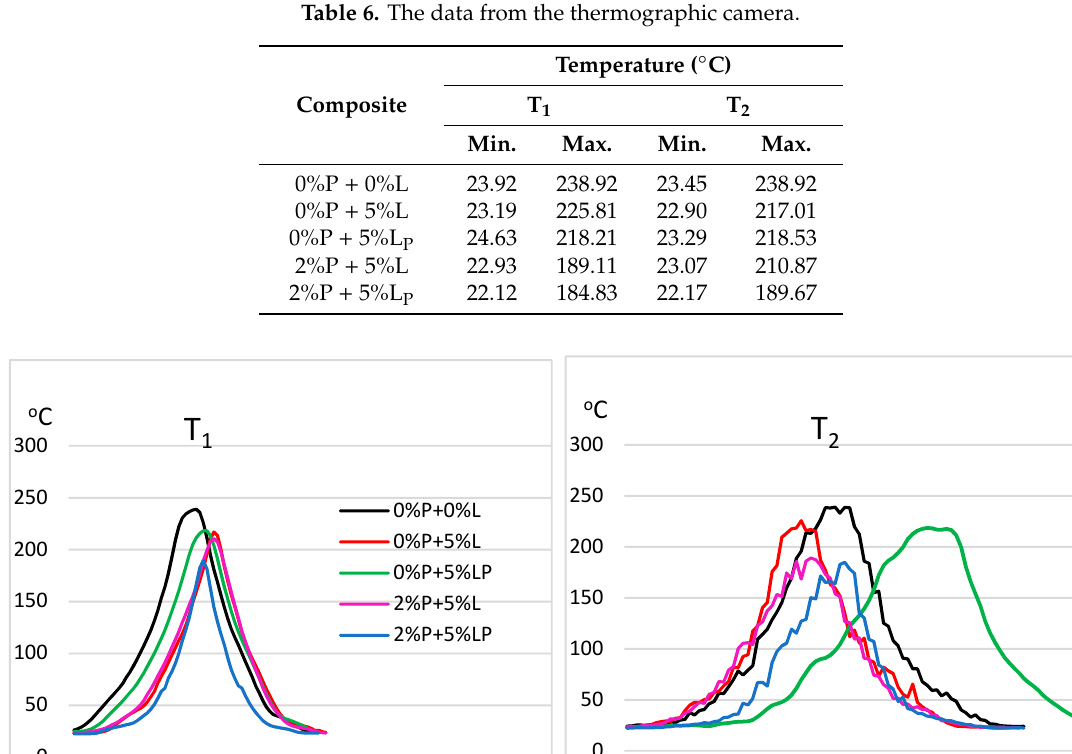
Table 6. The data from the thermographic camera.